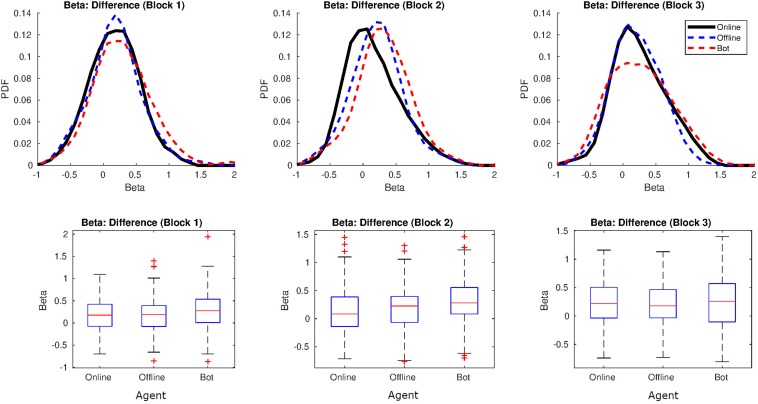
Distribution of β in Study 1. On the top: distributions for the values of β (in black online agent, in blue offline agent, in red the oscillatory bot). On the bottom, representation of the means and variances as boxplots.